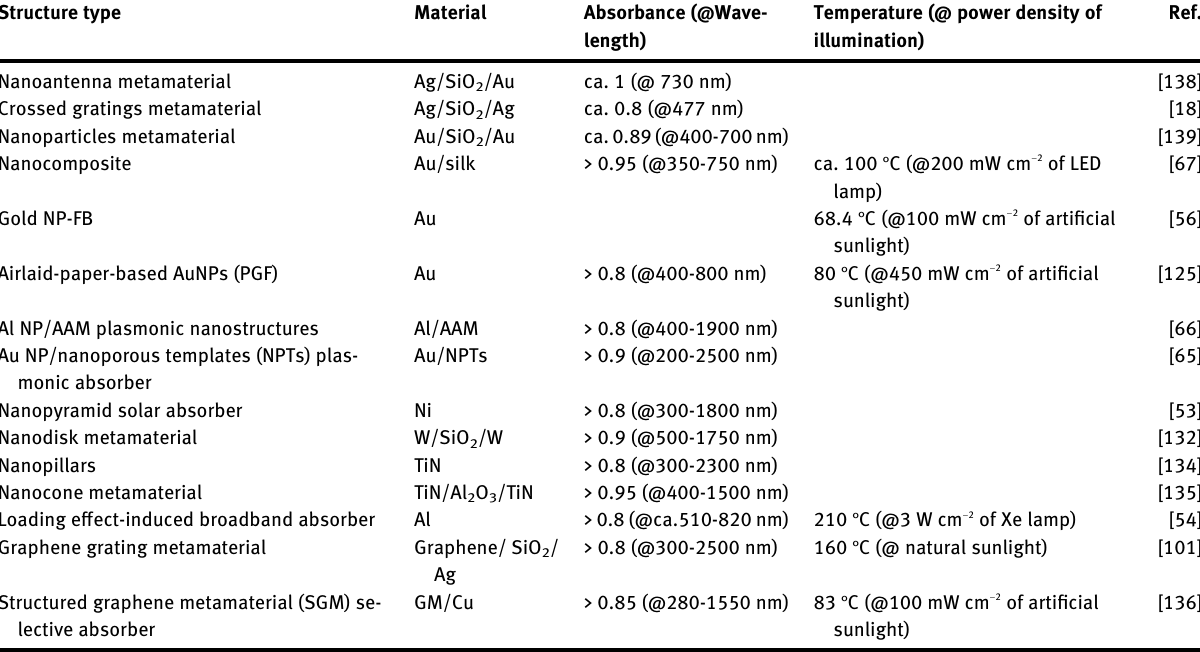
Table  : Properties (structure types, used materials, absorbance, and temperature) of recently reported electromagnetic absorbers. Structure